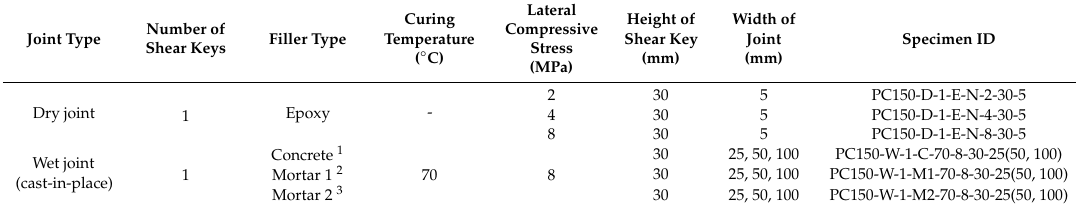
Table 3. Variables of push-o ff test ( f (cid:48) c = 150 MPa).